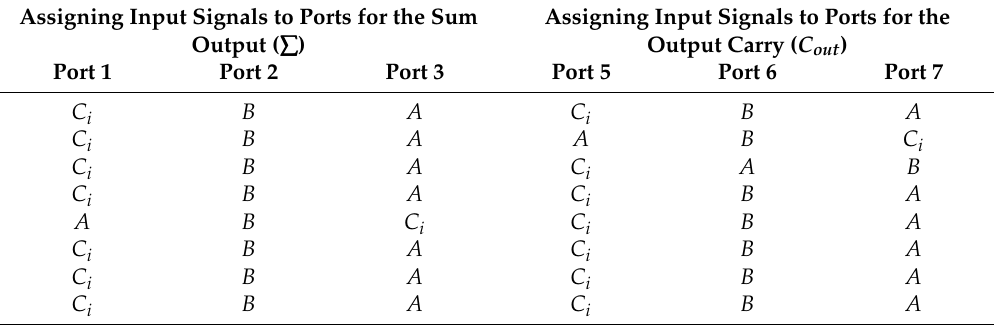
Table 4. Assigning input signals to ports of the outputs of the proposed plasmonic